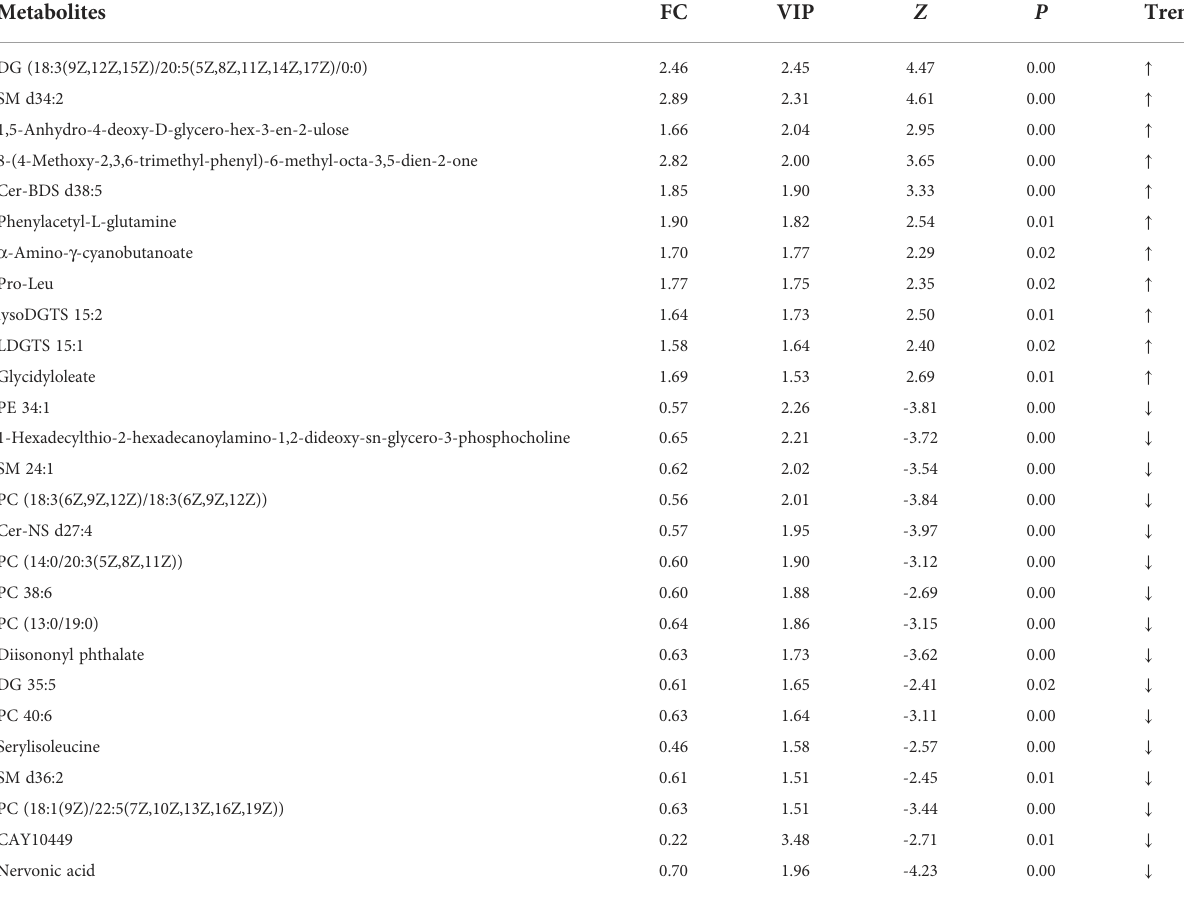
TABLE 3 Signi fi cantly differential metabolites between SLE and LN